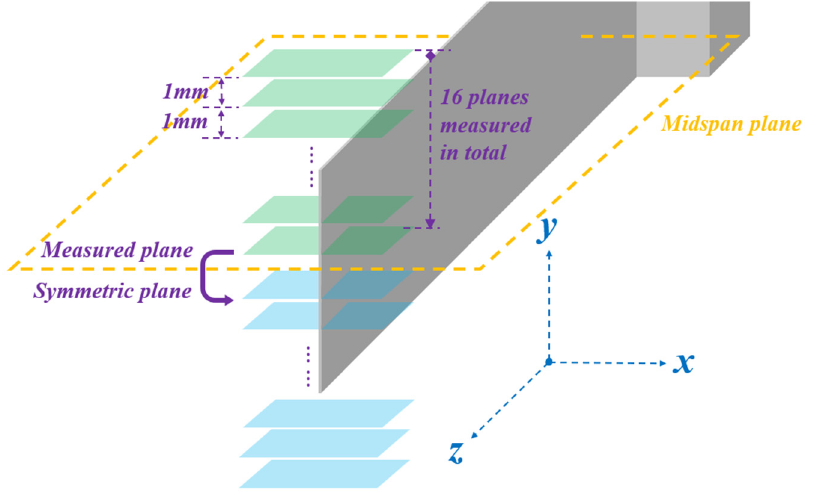
Figure 3. PIV measurement slices along the y axis with 1 mm apart in the transverse plane ( x - z